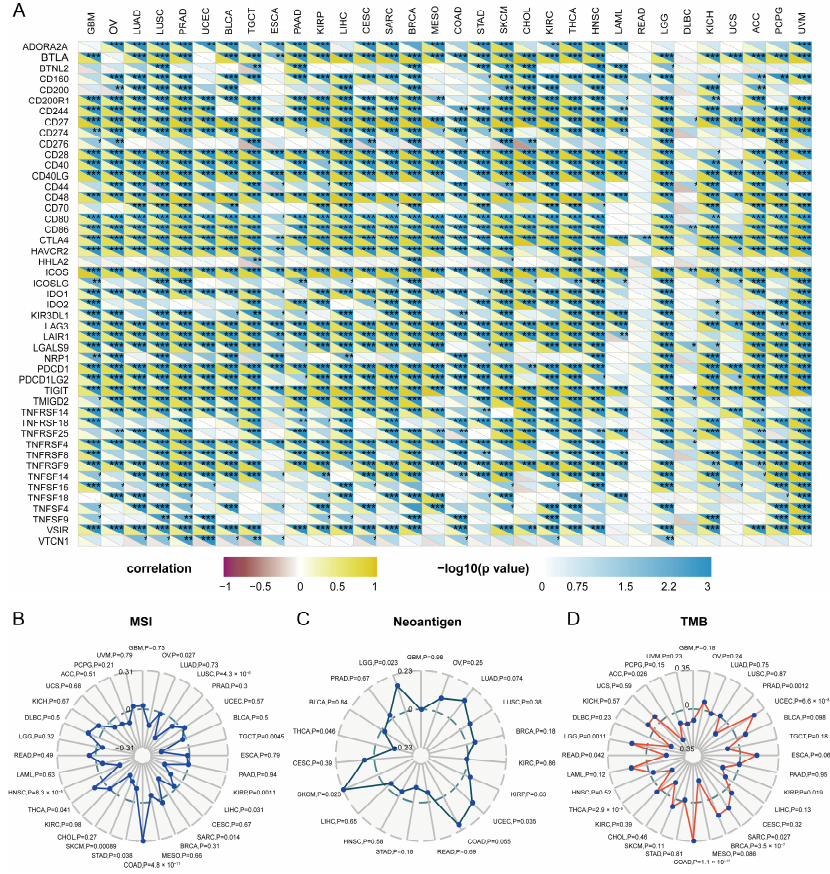
Figure 8. Correlations between LCK and immune checkpoints and other variables of interest. (* p < 0.05, ** p < 0.01, *** p < 0.001). ( A ) The correlations between LCK and confirmed immune checkpoints in multiple cancers. ( B – D ) The correlations of LCK expression and MSI, neoantigen, and TMB in tumors. Microsatellite instability (MSI), the number of neoantigens, and tumor mutation bur- den (TMB) in tumor cells mainly cause genetic recombination and aggravation. The cor- relation between LCK expression and MSI events across different tumors was analyzed.